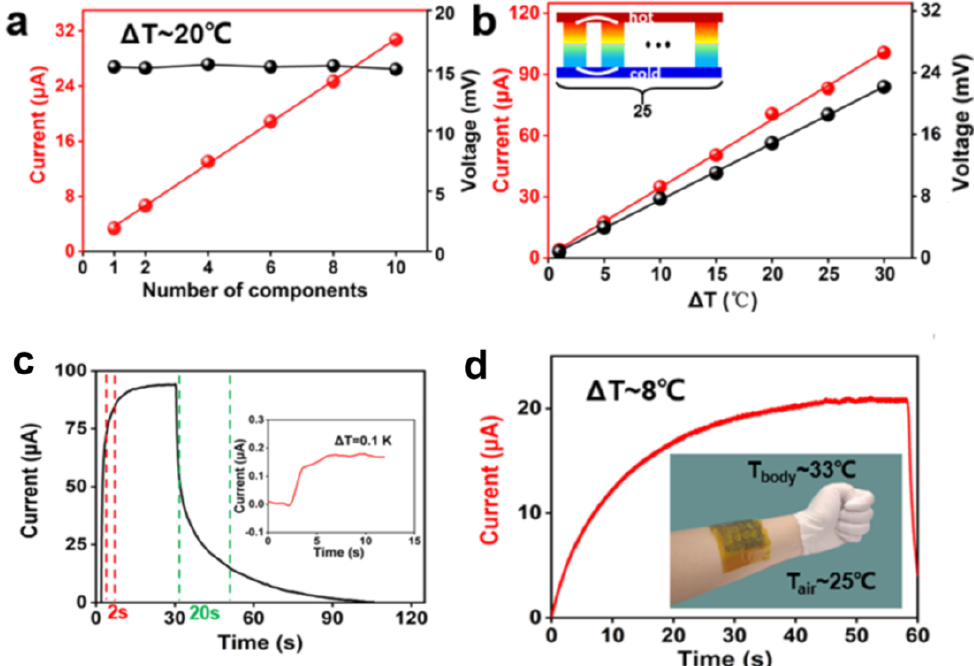
Figure 14. Thermoelectric performance of the integrated device under certain temperature difference conditions. ( a ) Output current and voltage of an integrated device consisting of different numbers of thermocells connected in parallel. ( b ) Current and voltage versus temperature difference for 25 parallel units. The illustration is a schematic diagram of 25 batteries in parallel. ( c ) Magnified current response curve vs. time. Inset: current − time curve under a temperature difference of 0.1 K. ( d ) Current output when the integrated patch device is pasted on the arm. Inset: photograph of the wearable thermocell on the arm. (Reproduced with permission from [118]. Copyright 2021 American Chemical Society).